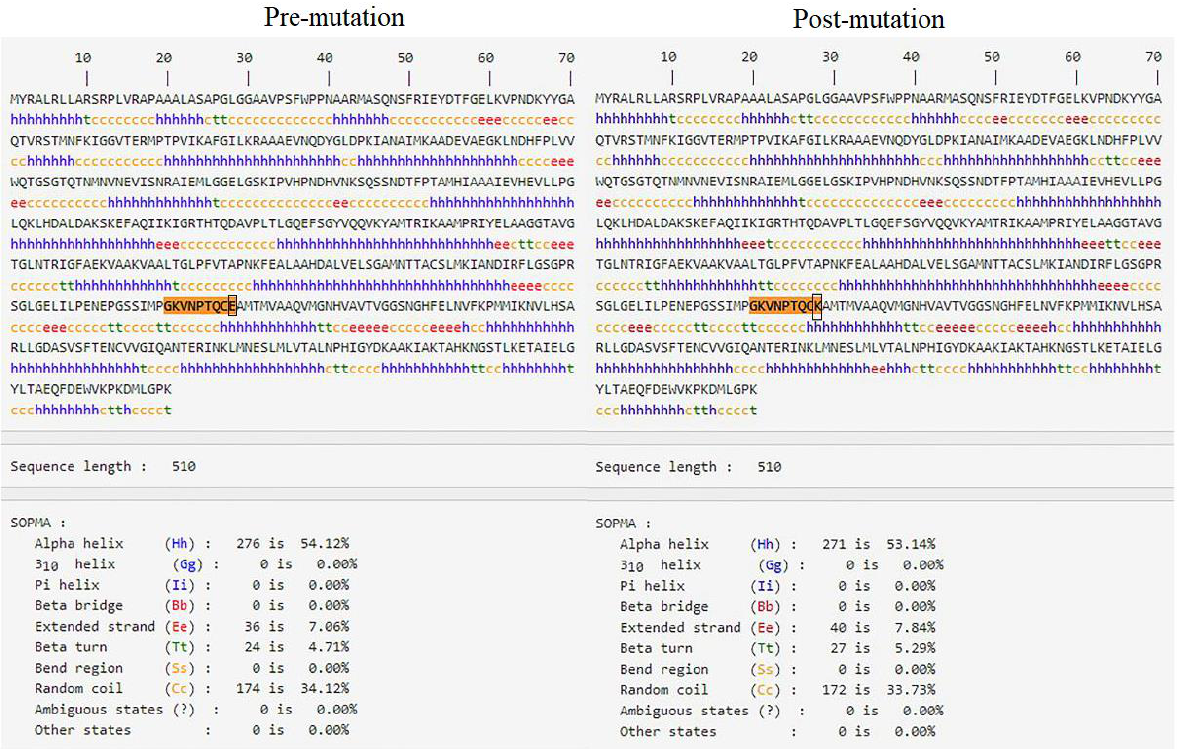
Figure 7. The predicted effects on the secondary structure by SOPMA database.